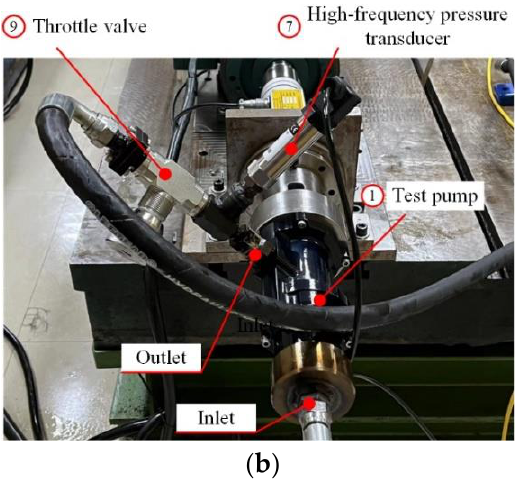
Figure 21. ( a ) The test system and ( b ) the test rig.